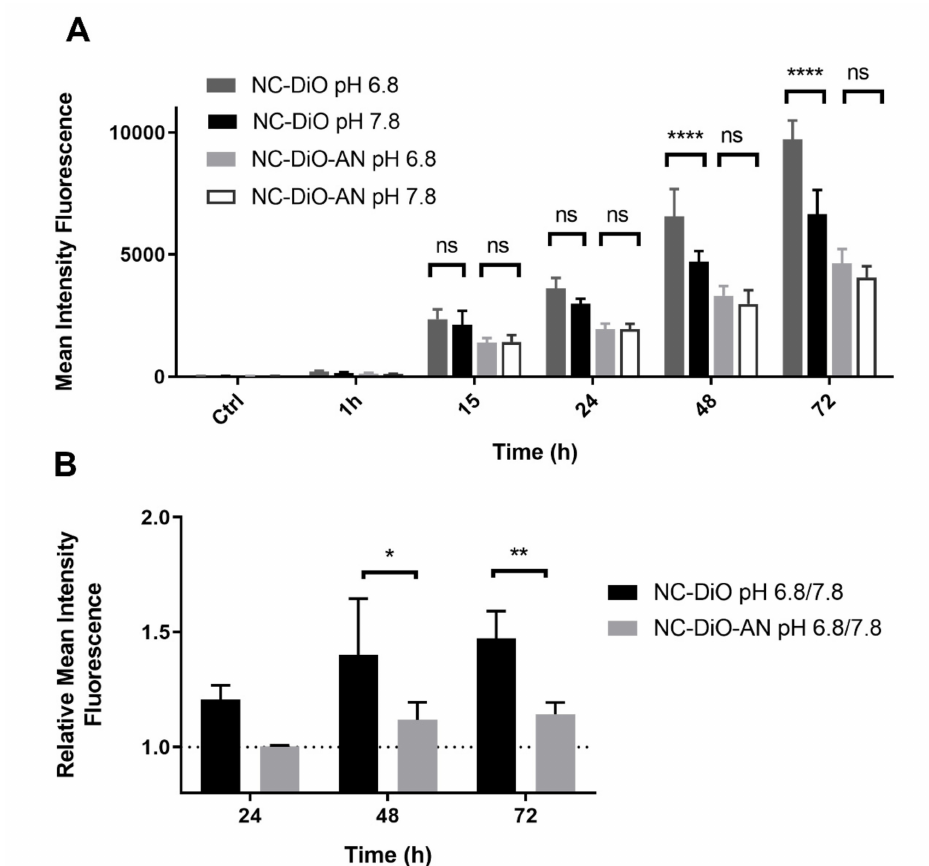
Figure 7. Nanocapsules uptake by flow cytometry. A549 cells were incubated with DiO loaded amphoteric (NC-DiO) or anionic (NC-DiO-AN) NCs at pH 6.8 or pH 7.8 for 1, 15, 24, 48, and 72 h. Fluorescence intensity was measured by flow cytometry. ( A ) Mean intensity fluorescence is represented ± SD of three independent experiments. ( B ) Mean intensity fluorescence ratio at pH